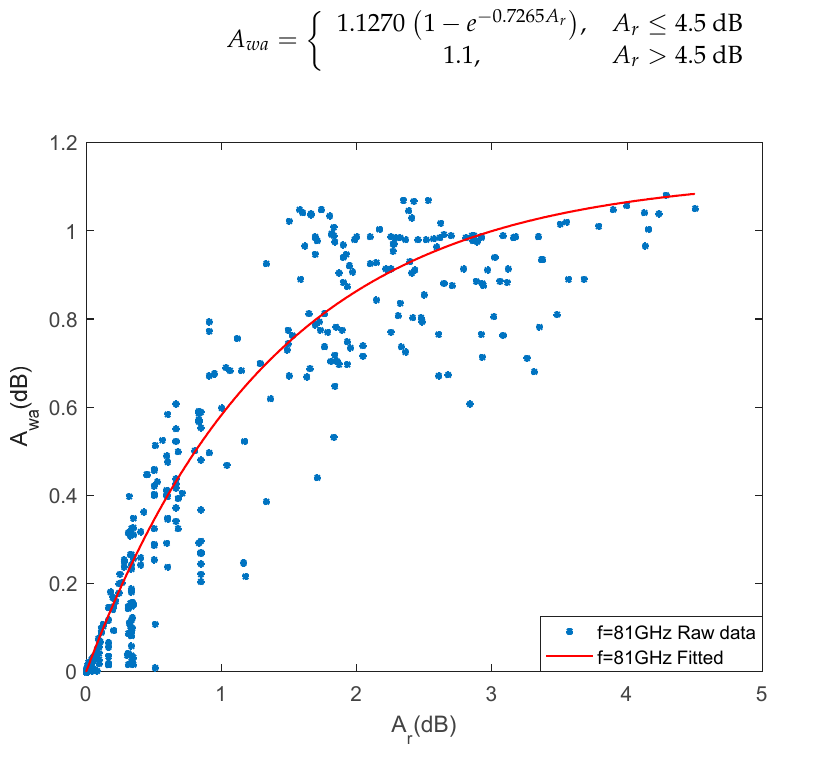
Figure 6. Curve fitting of A r and A wa at 81 GHz.